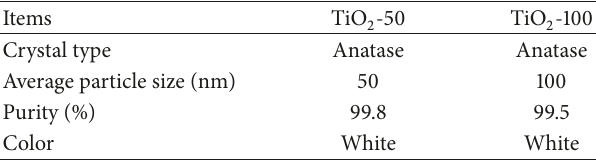
Table 2: Characteristics of nano-TiO 2